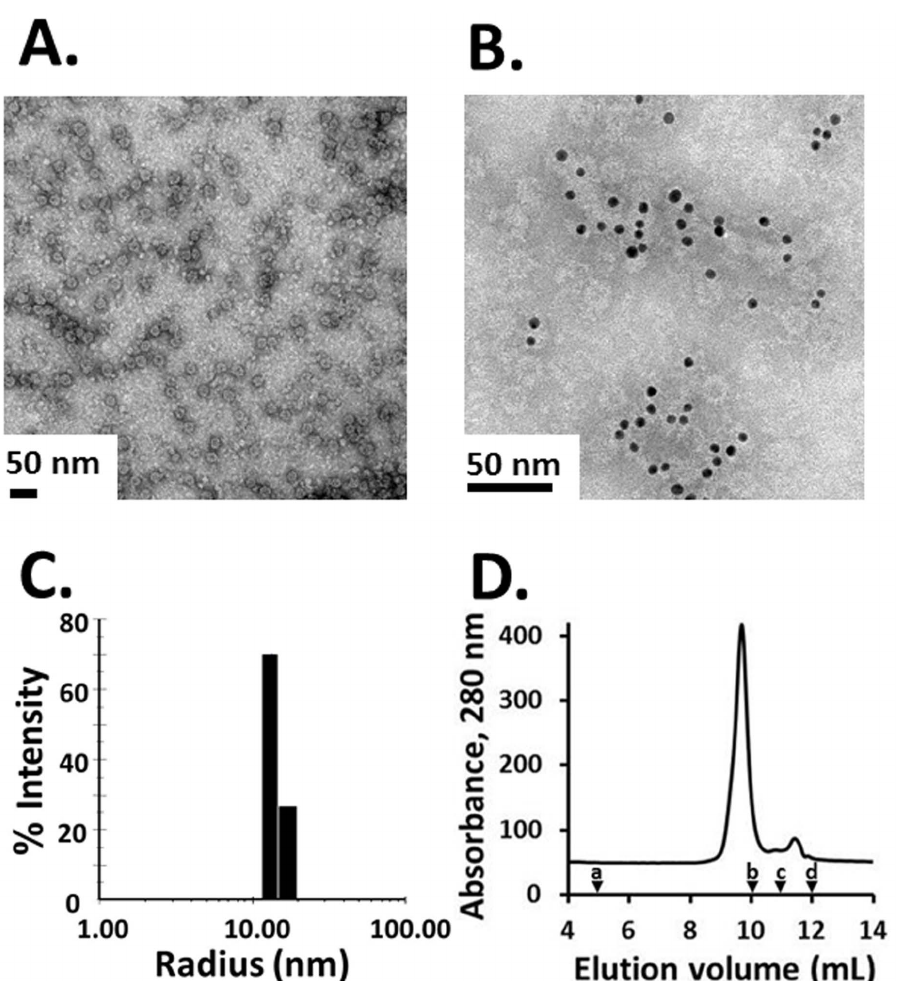
Figure 3. Pfs25-CP VLP particle analysis. (A) Negative stain transmission electron micrograph of Pfs25-CP VLPs shows highly uniform particles of 19.3 6 2.4 nm in diameter. (B) Transmission electron micrograph of Pfs25-CP VLPs labeled with anti-Pfs25 and gold-labeled anti-mouse antibodies confirms the presence of Pfs25 on the particles. (C) DLS histogram showing a narrow size distribution for Pfs25-CP VLPs. The average hydrodynamic radius is , 14 nm with a polydispersity of , 15%. (D) Analytical SEC showing a single, major eluting species confirmed by Western blot analysis (not shown) to be Pfs25-CP VLP. The void volume of the SRT 1000 column (range 7.5 MDa –50 kDa) is indicated by (a) molecular weight standards indicated by (b) for thyroglobulin, (c) for BSA and (d) for